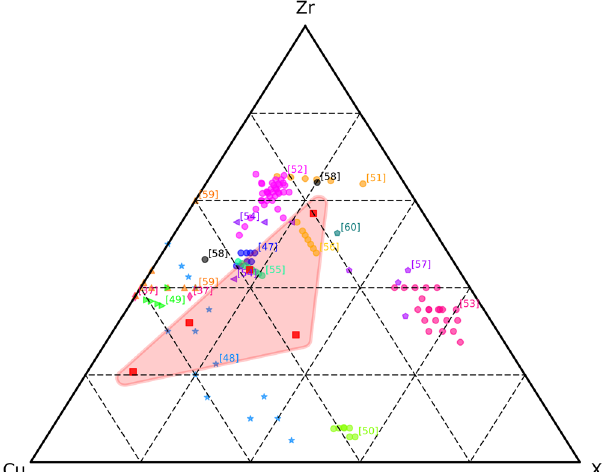
Figure 6. Chemical composition of BMGs from this study and literature are shown 37, 47–60 . All elements except Cu and Zr are summed up in X to enable a comparison. In this study, the chemical composition is changed by dissolving Cu into the Zr-MG and the range is marked. An additional composition with Zr-MG 20 wt% Cu 10 wt% Ni is added to show the extensive range of possible